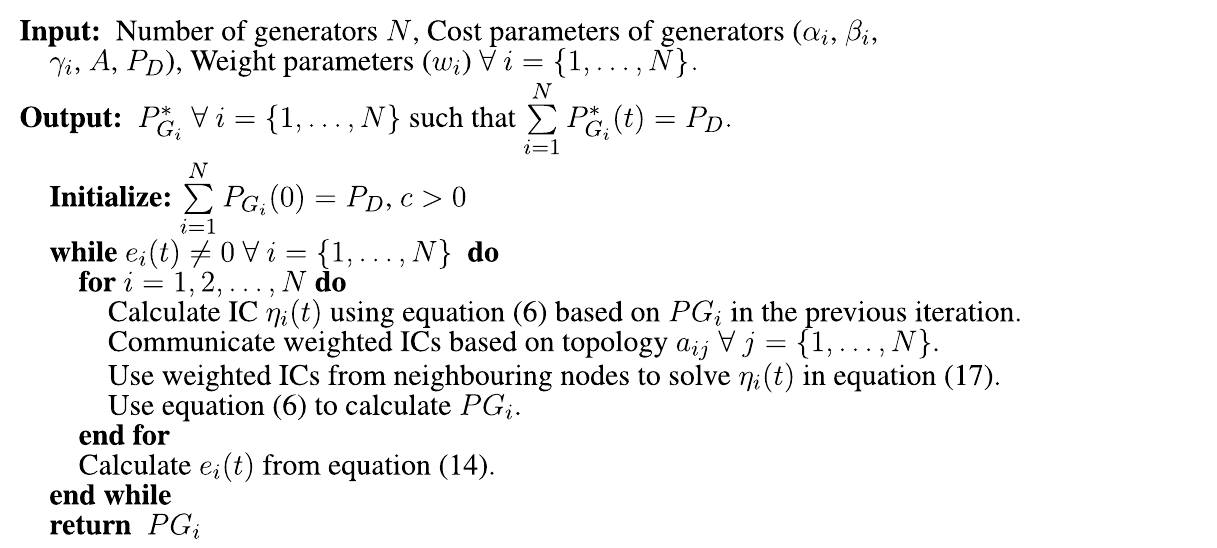
Algorithm 1 | Weighted IC Consensus